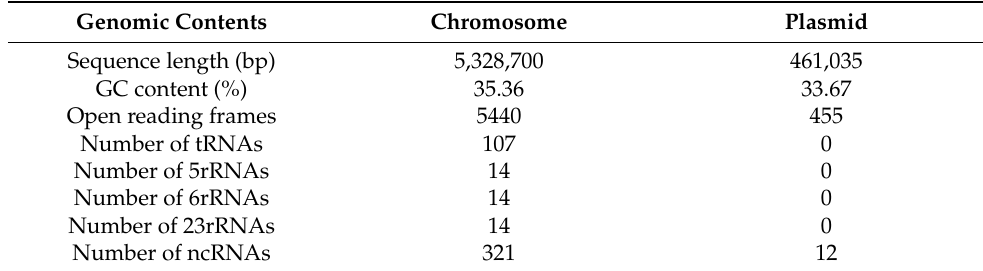
Table 1. Genomic characteristics of B. cereus AH7-7.